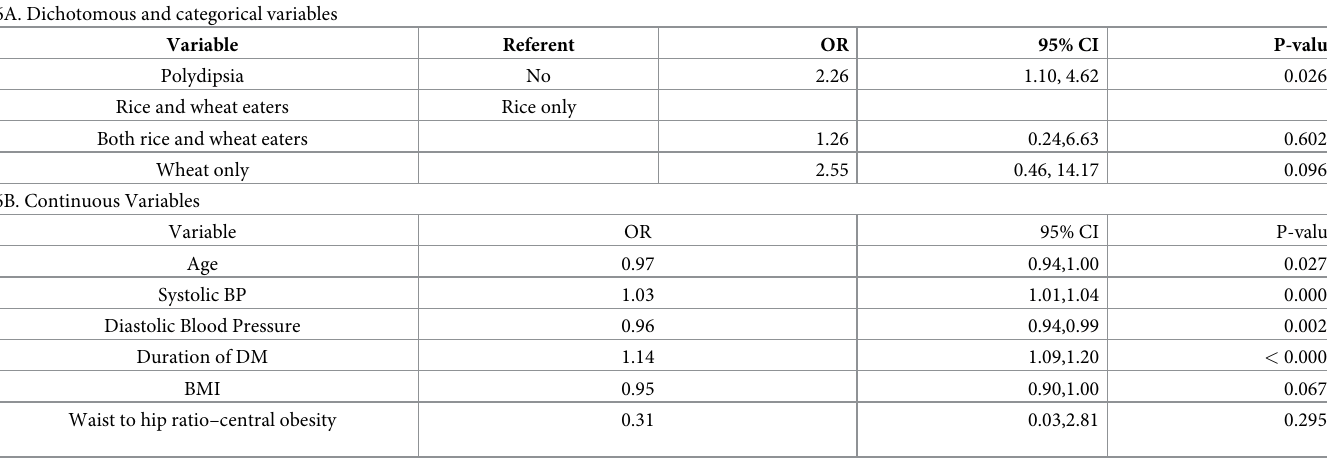
Table 6. Stepwise multivariate Sex stratified analysis of DR